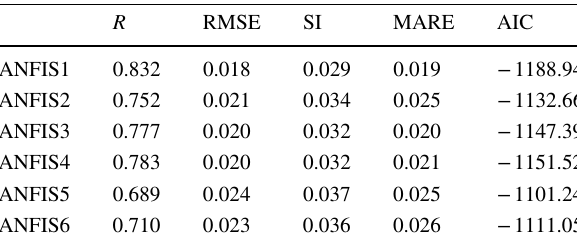
Table 3 Results of different statistical indices for six models